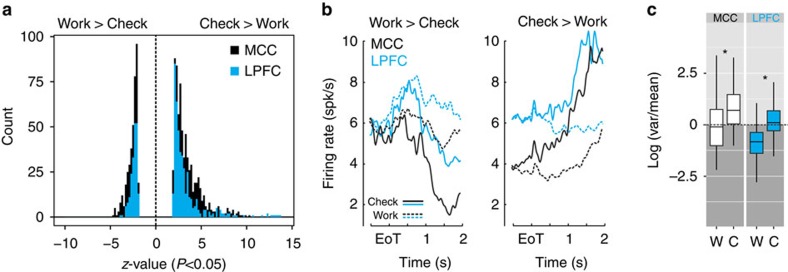
Bias for Check and dynamic of firing rate.(a) Both MCC and LPFC show more cases with higher activity in Check compared with Work at decision time. The population histograms show the individual cell Z-values from the sliding glm for all time bins for all cells (see Fig. 4). (b) Average population activity shows for all cases greater dynamical changes for decision to Check (plain lines) than for decisions to Work (dashed). PSTH are displayed for subpopulations of cells that had higher activity in Work than in Check (left), and that had higher activity in Check than in work (right). Data for each decision (Check: lines; Work: dashed lines) and each structure (MCC: black, LPFC: blue). (c) Normalized variance of activity across bins is higher for Check than Work in both structures. Stars indicate significance at P<10−3, analysis of variance on log values (Check versus Work decision × Check versus Work preference).